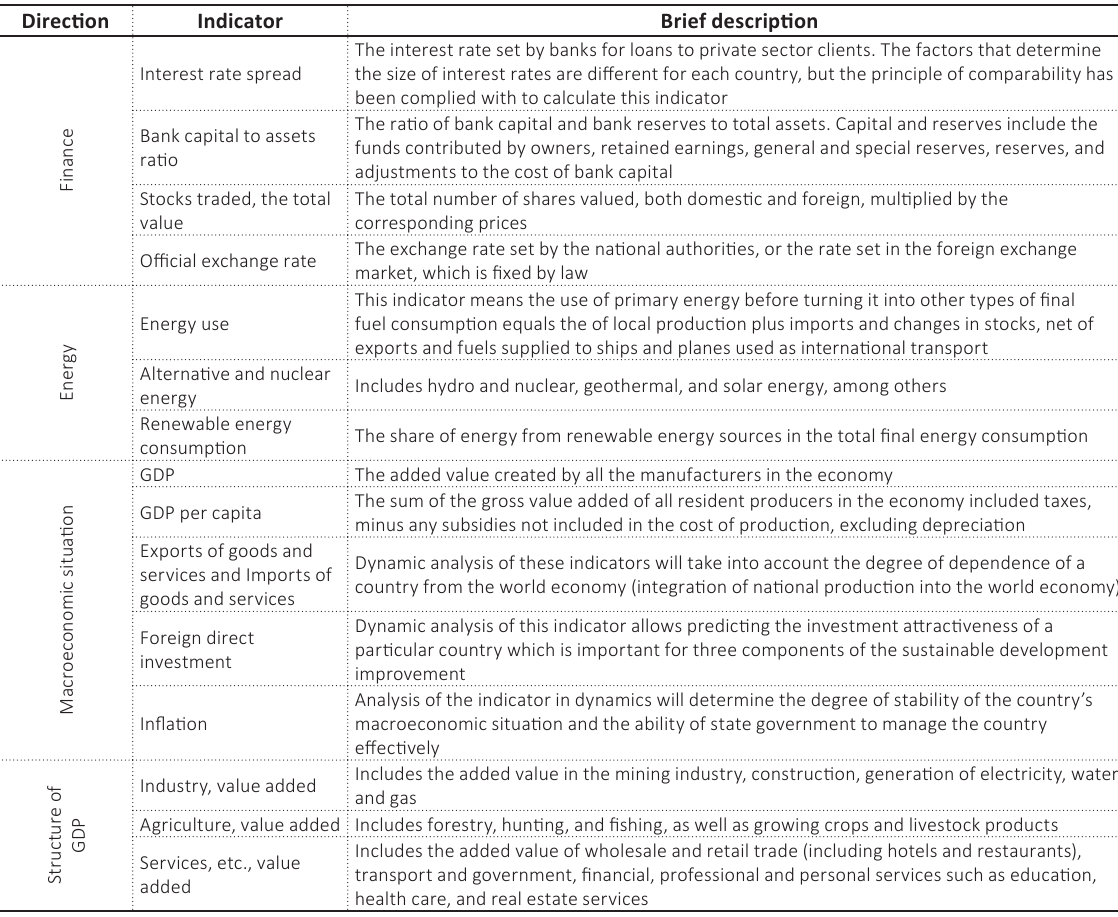
Table 2. The primary set of indicators for scenario modeling of the countries’ sustainable development